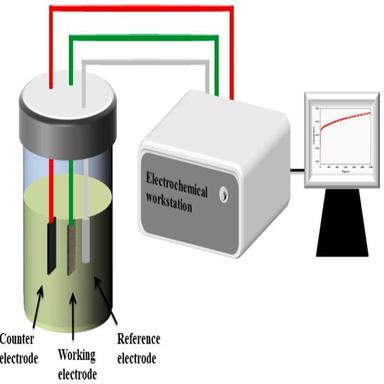
The electrodeposition device diagram of CdSe materials.